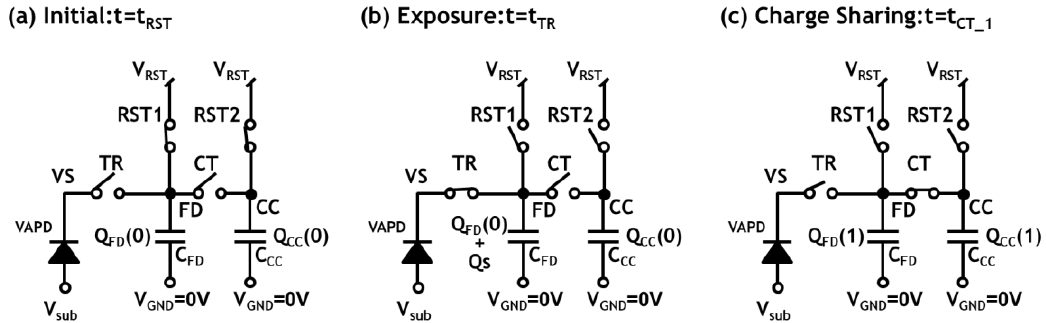
Figure 15. Pixel circuit diagrams during the charge transfer process. Transistors are represented by switches. The reset voltage through RST1 and RST2 are assumed to be identical, V RST .